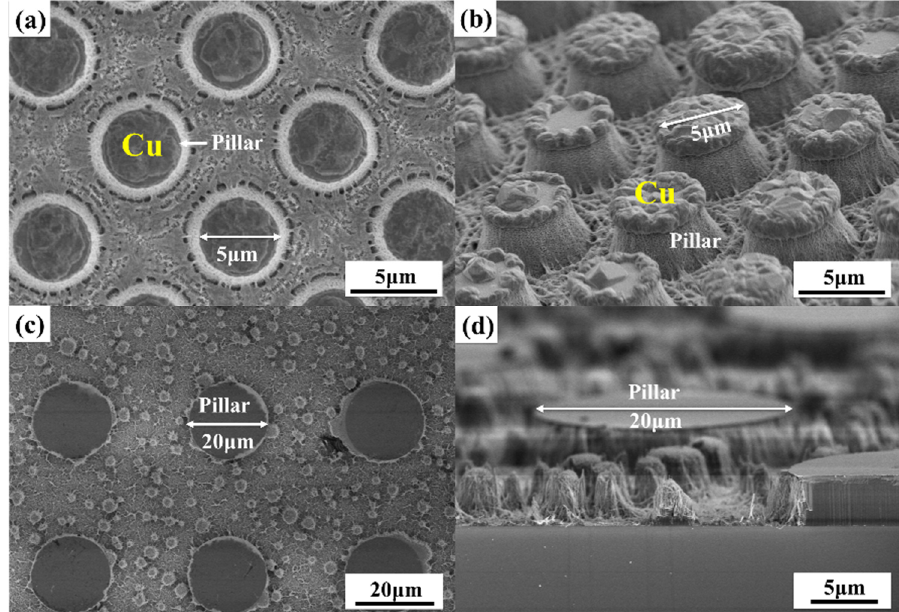
Figure 7. Plane view and cross-sectional SEM images of the obtained GaN microstructures using MacEtch with different mask materials: ( a , b ) Ni/Ag mask and ( c , d ) SiN mask.